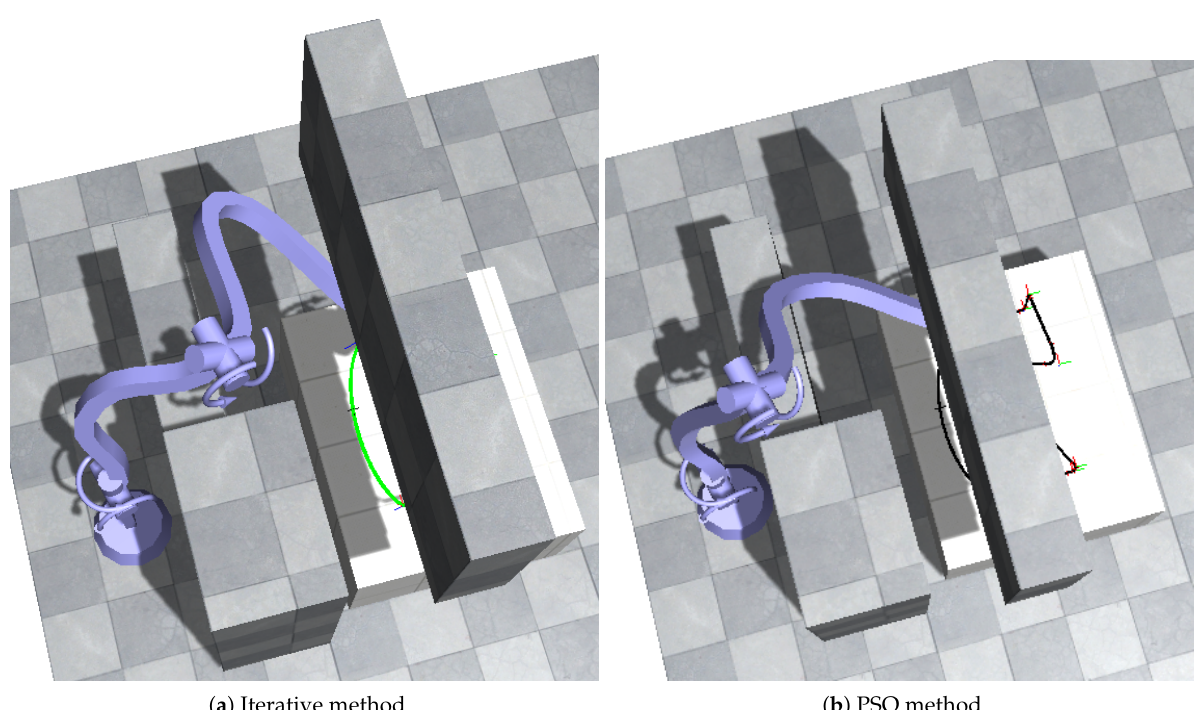
Figure 12. Results for the second testing